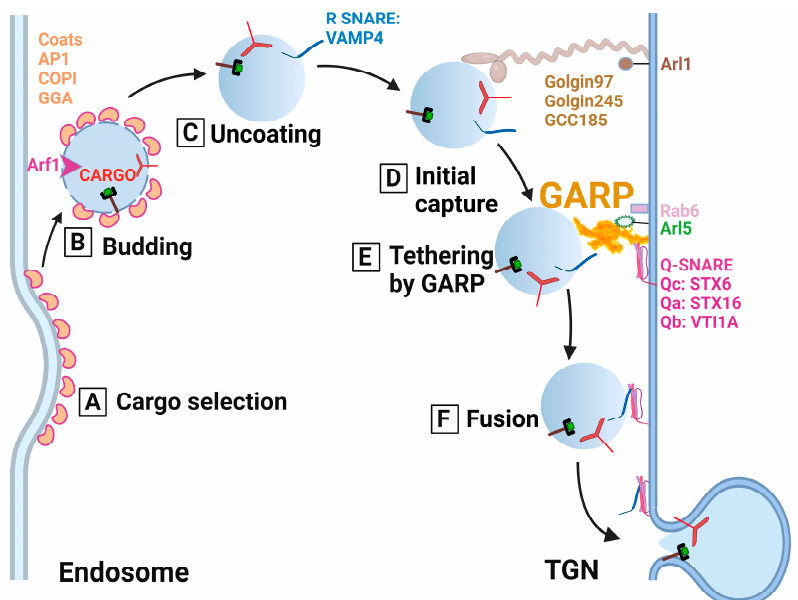
Figure 3. Cartoon depicting the predicted role of the GARP complex and other tra ffi cking compo- nents in the tethering of endosome-derived vesicles to the TGN. (A) Cargo selection: Recycling sol- uble and transmembrane cargo molecules such as the mannose-6-phosphate receptor and TGN46 are selected and packaged in the tra ffi cking intermediates (vesicle) using ARF1 GTPase and a vesic- ular coat (AP1, GGA or COPI). (B) Budding: After the vesicle is formed, it is budded o ff the endoso- mal compartment. (C) Uncoating: ARF1 hydrolyzes GTP, and the coat gradually falls o ff . (D) Initial capture: Once the vesicle reaches proximity to the TGN, coiled-coil tethers (Golgin97, Golgin245, and GCC185) perform the initial capture. (E) Tethering by GARP: GARP complex binds coiled-coil tethers and SNAREs to control and coordinate docking of the vesicle with the TGN membrane. (F) Fusion: Following the tethering by the GARP complex, the trans -SNARE complex is formed, which results in vesicle fusion with the TGN to deliver the recycling